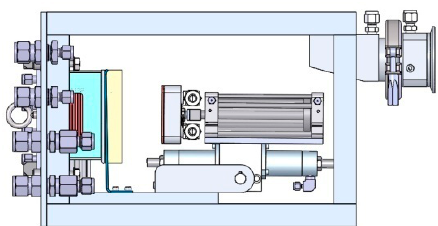
Figure 6. The irradiated target ready for dissolution.